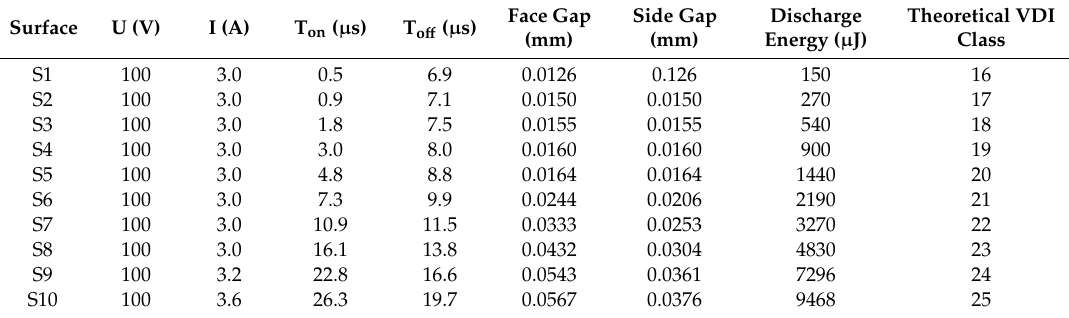
Table 3. Technological parameters of the finishing